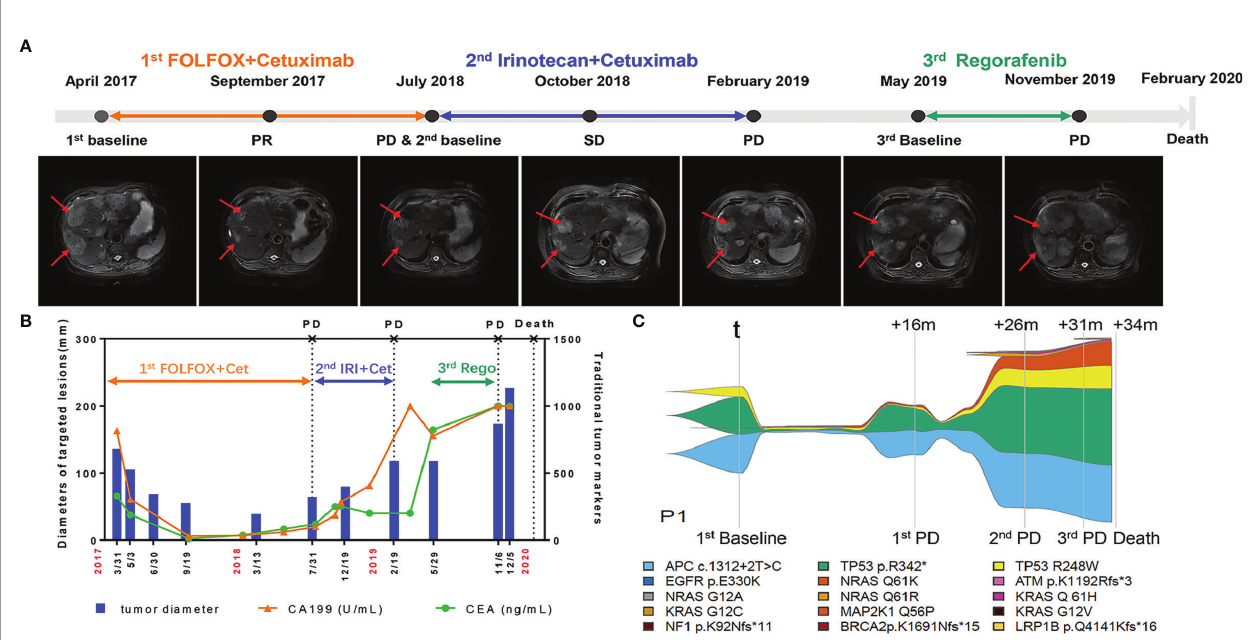
FIGURE 3 | Longitudinal radiograph and ctDNA detection of one representative CRC patient. (A) Radiographic features of tumor lesions in a 73-year-old male with colorectal cancer liver metastasis. PR, partial response; SD, stable disease; PD, progressive disease. (B) Comparison of the changes of tumor diameter, CEA and CA199 in patient 1(P1). Cet: Cetuximab; IRI, Irinotecan; Rego, Regorafenib. (C) Example of a serial ctDNA testing in P1 showing emergence of clonal alterations with treatment process. The changes of line thickness indicate the changes of variant allele frequency (VAF) of genomic alterations. The thicker line corresponds to larger VAF. Colors of speci fi c genomic alterations shown on the